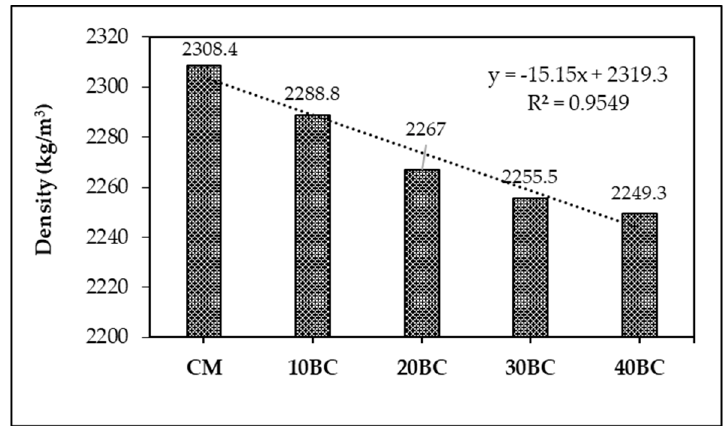
Figure 6. Fresh concrete density of concrete mixes.